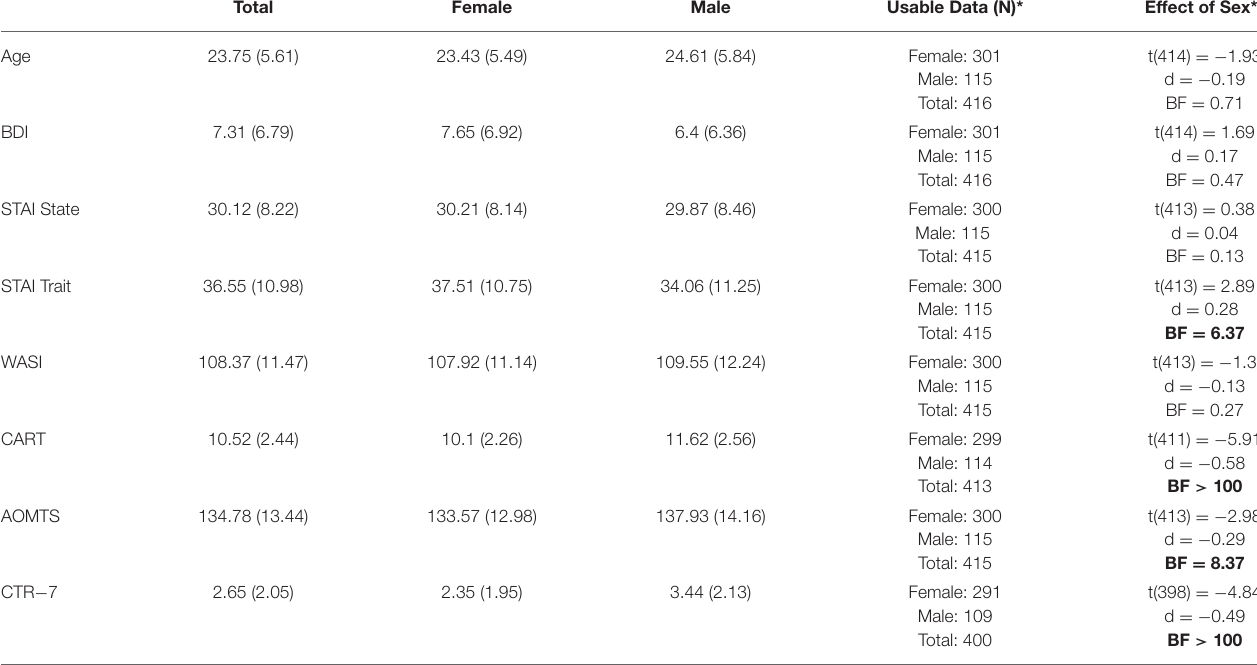
TABLE 1 | Descriptive statistics and tests of sex differences for age, symptoms, and